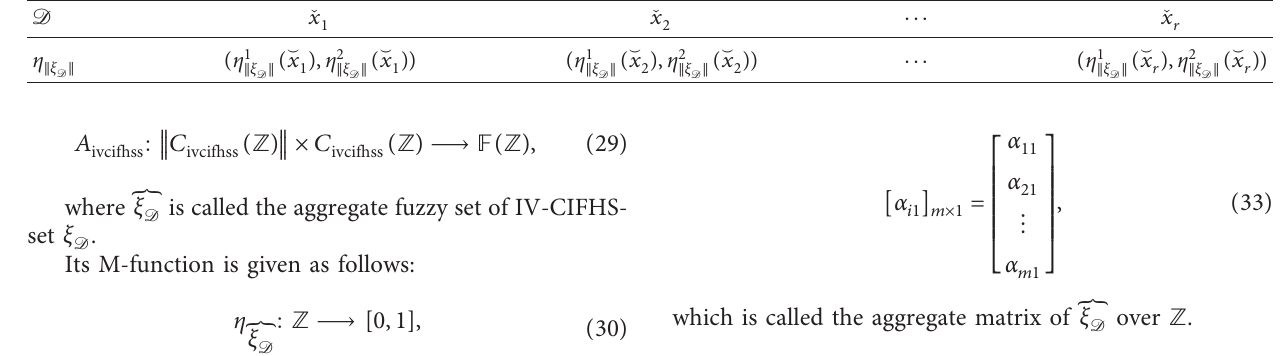
Table 4: Tabular representation of ‖ ξ